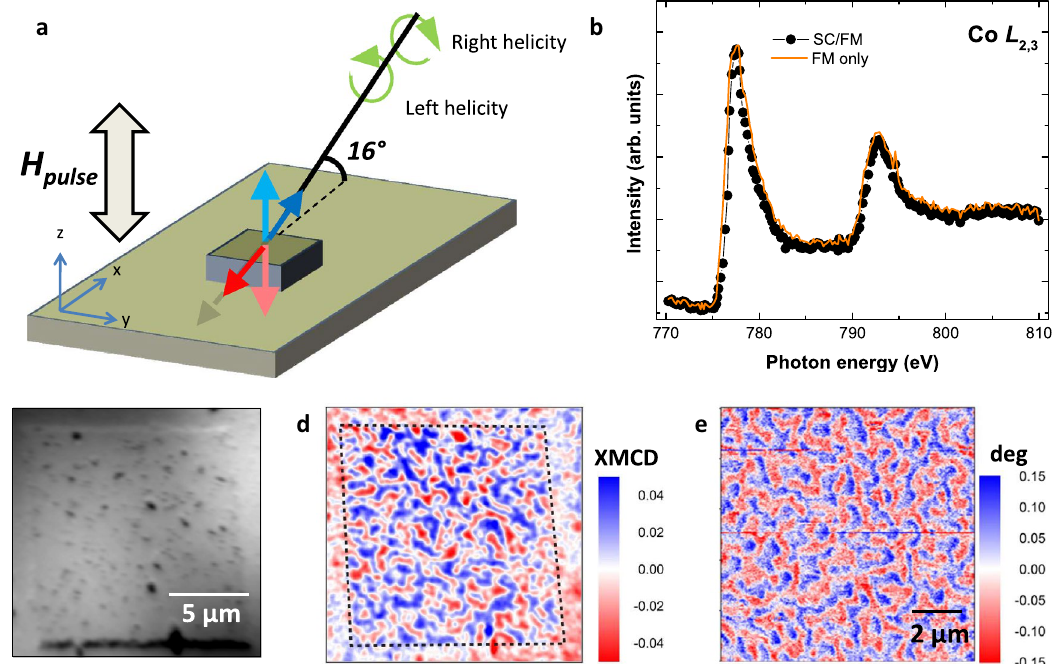
Figure 1. ( a ) Sketch of the experimental set-up. XMCD, measured as the normalized difference in absorption for incoming left and right helicity of circular polarized radiation, is proportional to the projection of the magnetization (light red and blue arrows) along the beam propagation direction (red and blue arrows). ( b ) Absorption spectrum obtained at the Co L 2,3 -edges for (Co/Pt) 5 on top (dots) and around the SC structure (line). ( c,d ) XAS and XMCD images obtained at Co L 3 -edge (777.55 eV) at 50 K after a demagnetization process at 140 K. ( e ) MFM phase image showing similar magnetization